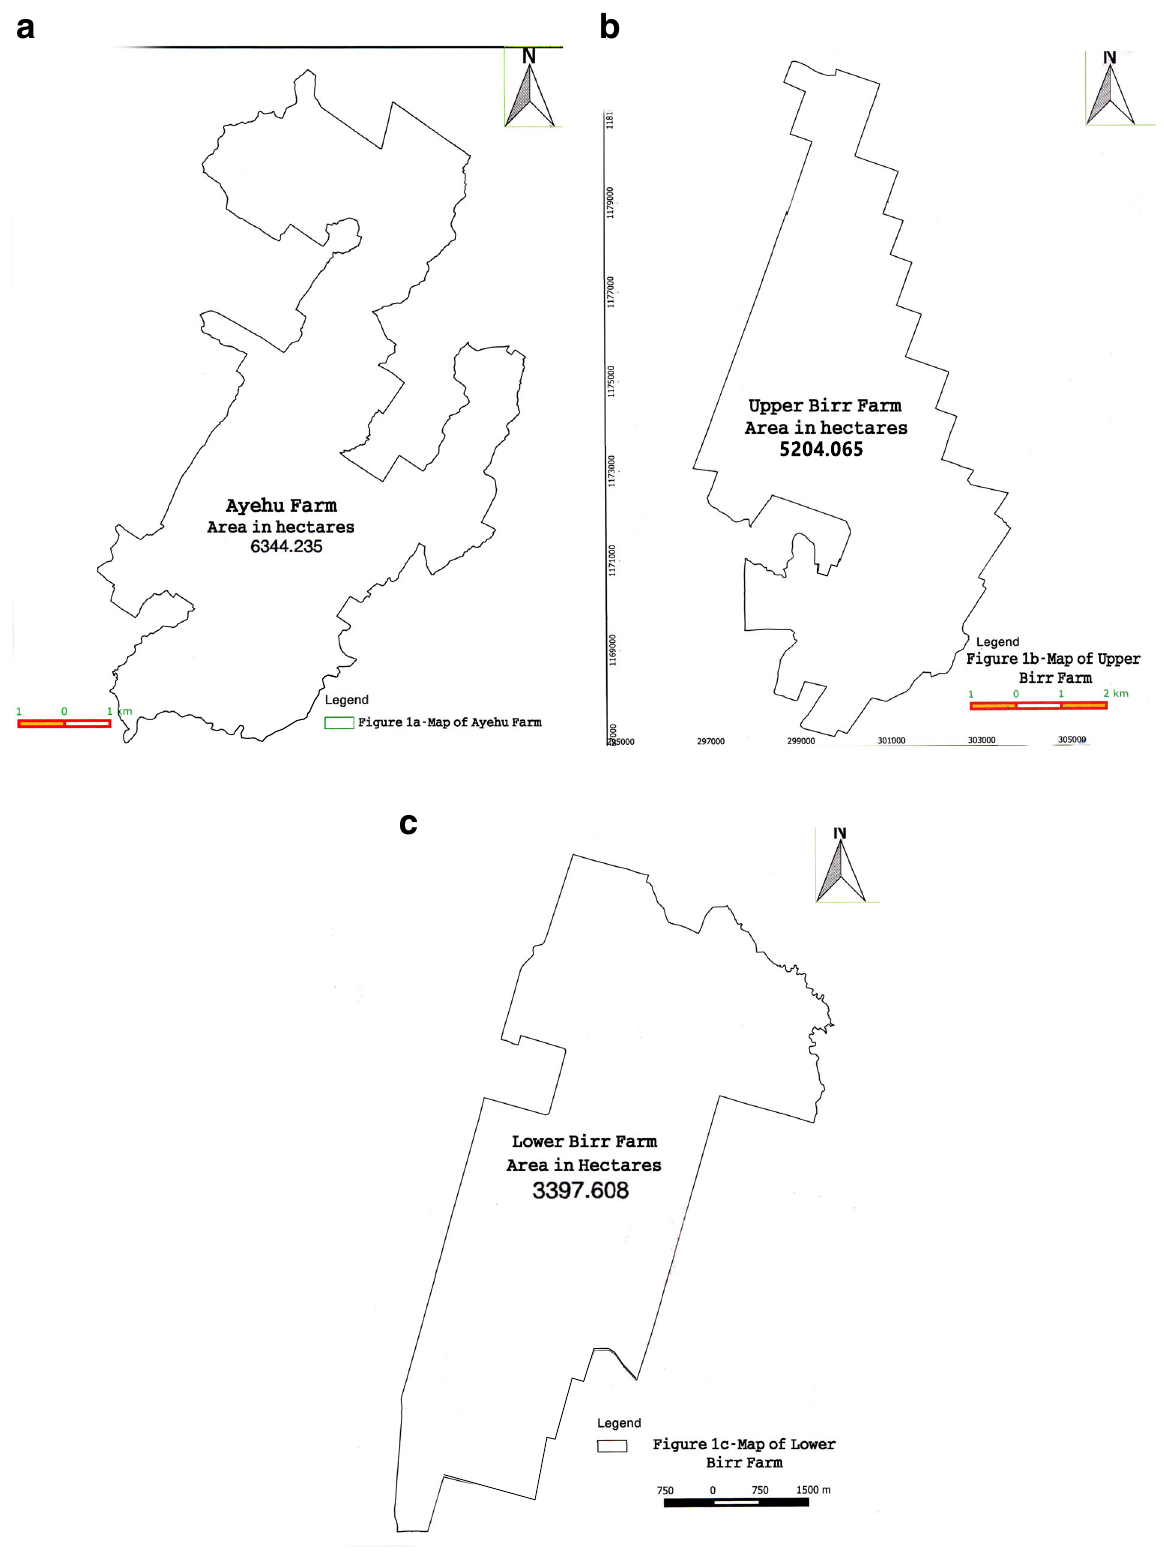
Fig. 1 Geographical map of Ayehu farm. a Refers to the geographical map of Ayehu farm found in Awi Administrative Zone of Amhara region. This farm was commenced on 46 ha of land in 1982 in the former Ankassa Gugusa district as a state-owned enterprise. b and c indicates the geographical map of upper and lower Birr farm, respectively, which is found in Jabi Tehnan district of West Gojjam zone of Amhara region. It is the earliest commenced farm in Gojjam province during the Derg regime as a public enterprise in 1978.